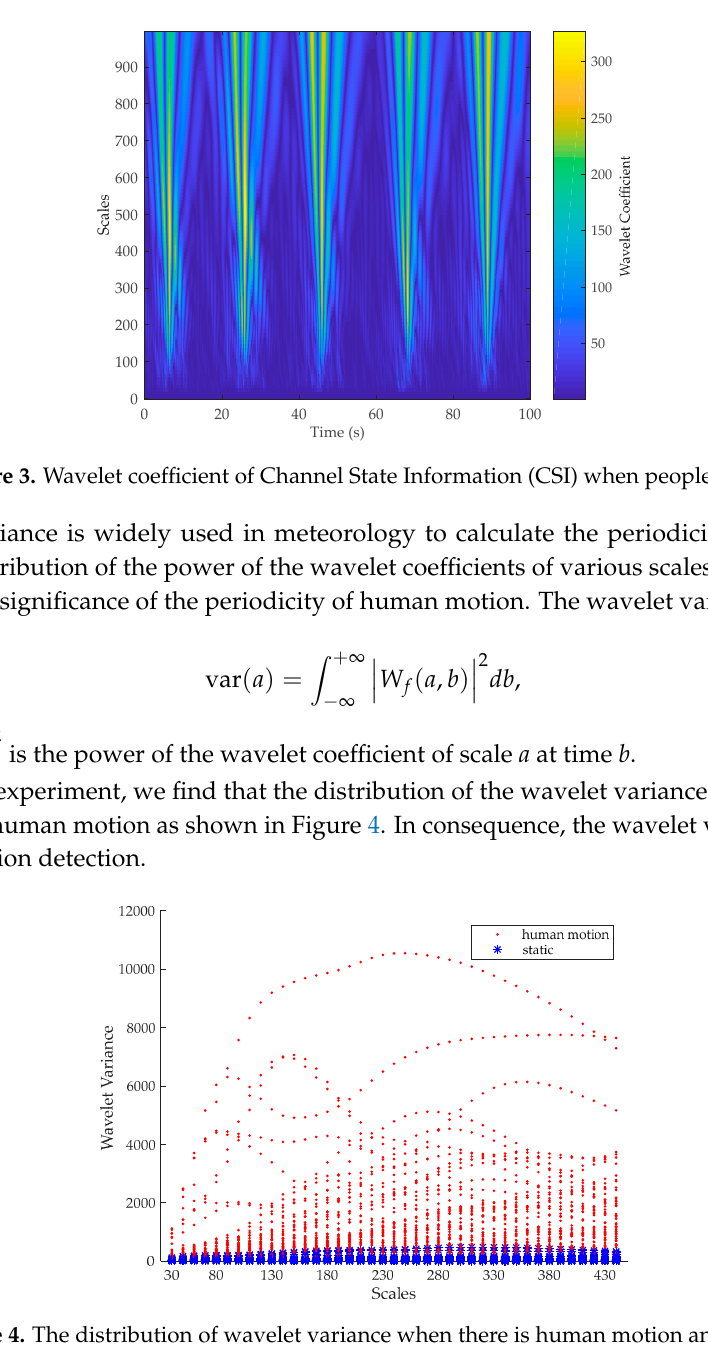
Figure 4. The distribution of wavelet variance when there is human motion and static.